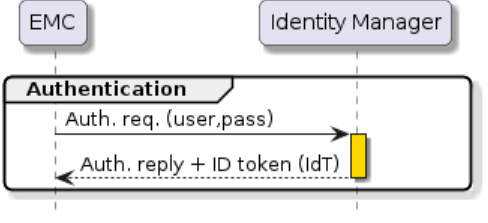
Figure 8. Authentication sequence.